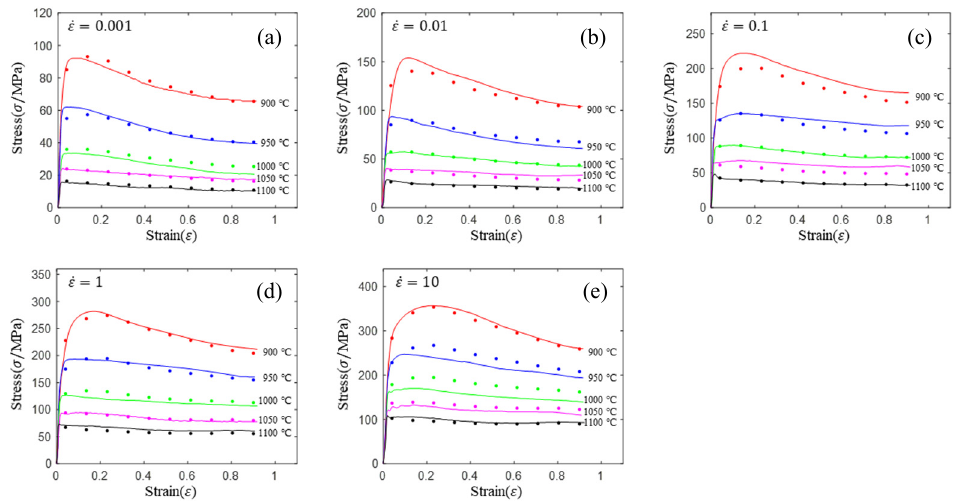
Figure 4. Comparison of prediction flow stress and experimental flow stress for Arrhenius model: ( a ) 0.01 s − 1 ; ( b ) 0.1 s − 1 ; ( c ) 1 s − 1 ; ( d ) 10 s − 1 ; ( e ) 10 s − 1 .